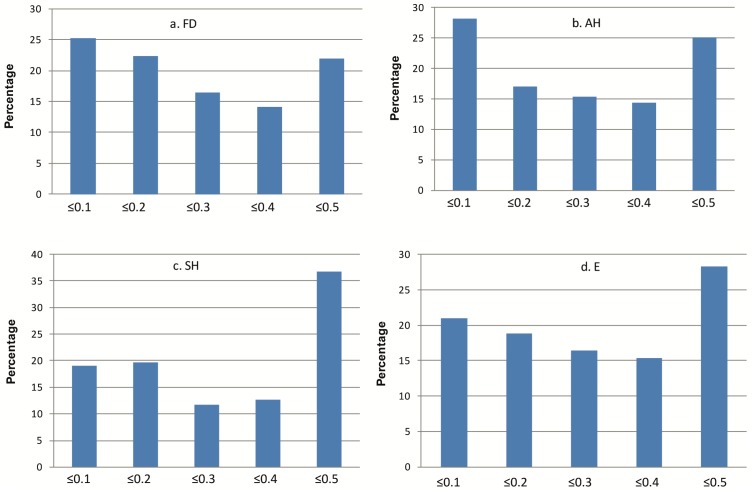
Nei’s diversity index (DI) distribution across FIGS Drought (a), Australia Hot (b), synthetic hexaploids (c) and elites (d).Each column represents percentage of markers having DI either equal to or less than the value shown on X-axis.